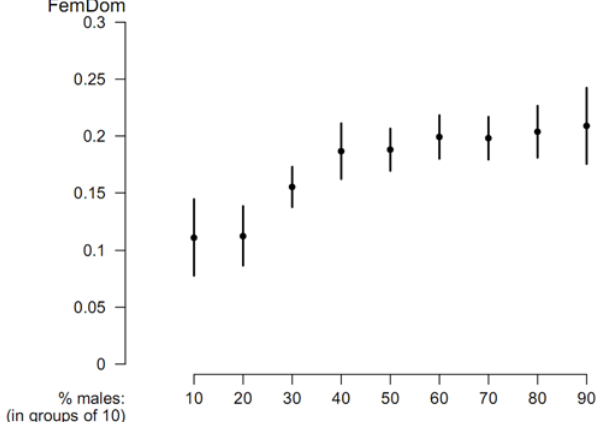
Figure 1. Mean and standard error of female dominance over males (FemDom) for different percentages of males in the group in the model. Intensity of aggression (StepDom) of males=1, of females=0.1, initial dominance of females and males is 16 and 32, respectively.